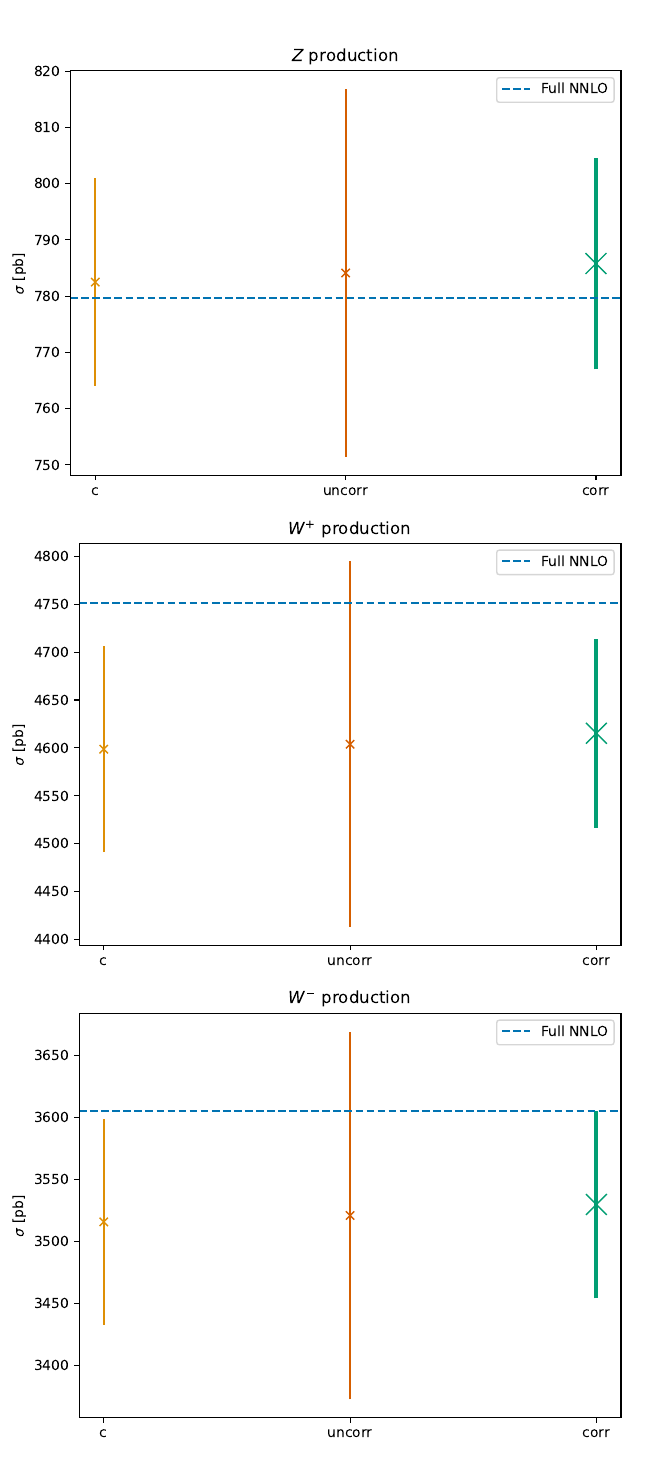
Figure 12 . The same as figure 3 but for Z (top), W + (middle) and W − (bottom) production at √ s = 13